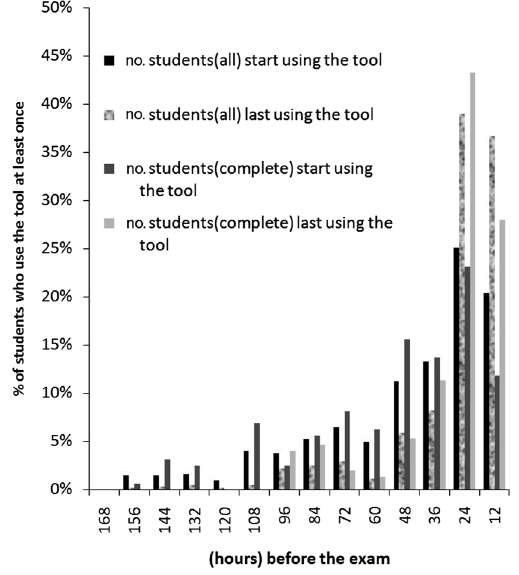
FIG. 1. Student interaction with exam-prep tool. The highest usage was during the 24 h prior to the exam. Of the 1100 students enrolled in the course, 769 tried at least one question, 494 tried at least half, and 160 did all of the